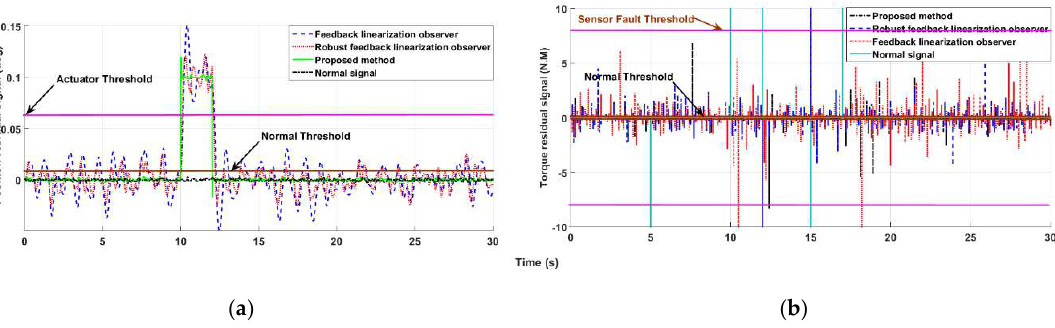
Figure 12. Actuator fault identification residual signals: ( a ) position and ( b ) torque for the fuzzy ARX-Laguerre feedback linearization method, the fuzzy ARX-Laguerre robust feedback linearization method, and the fuzzy ARX-Laguerre T–S fuzzy robust feedback linearization method for the surgical robot for the sinus.